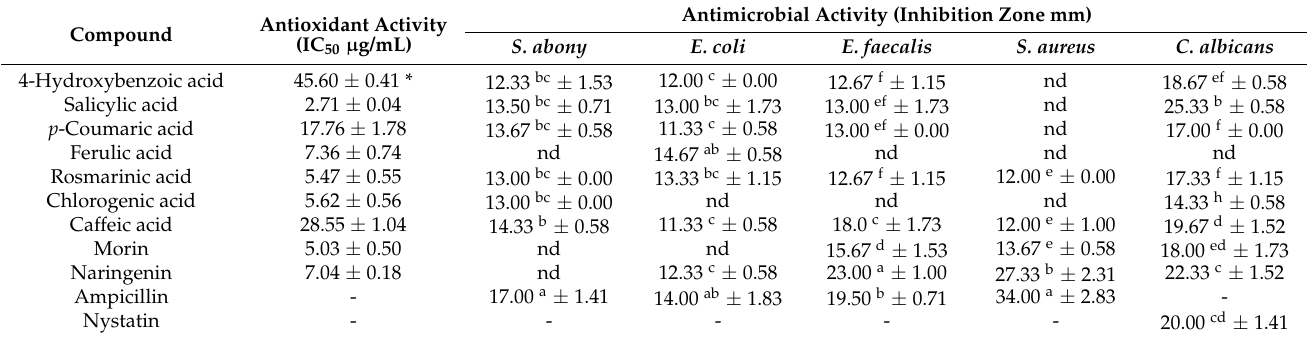
Table 3. Antioxidant and antimicrobial activities of the phenolic constituents of G. lutea .